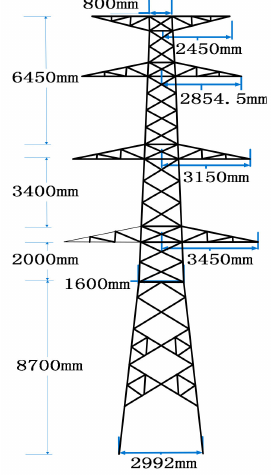
Figure 6. The geometry and major dimensions of the umbrella tower.